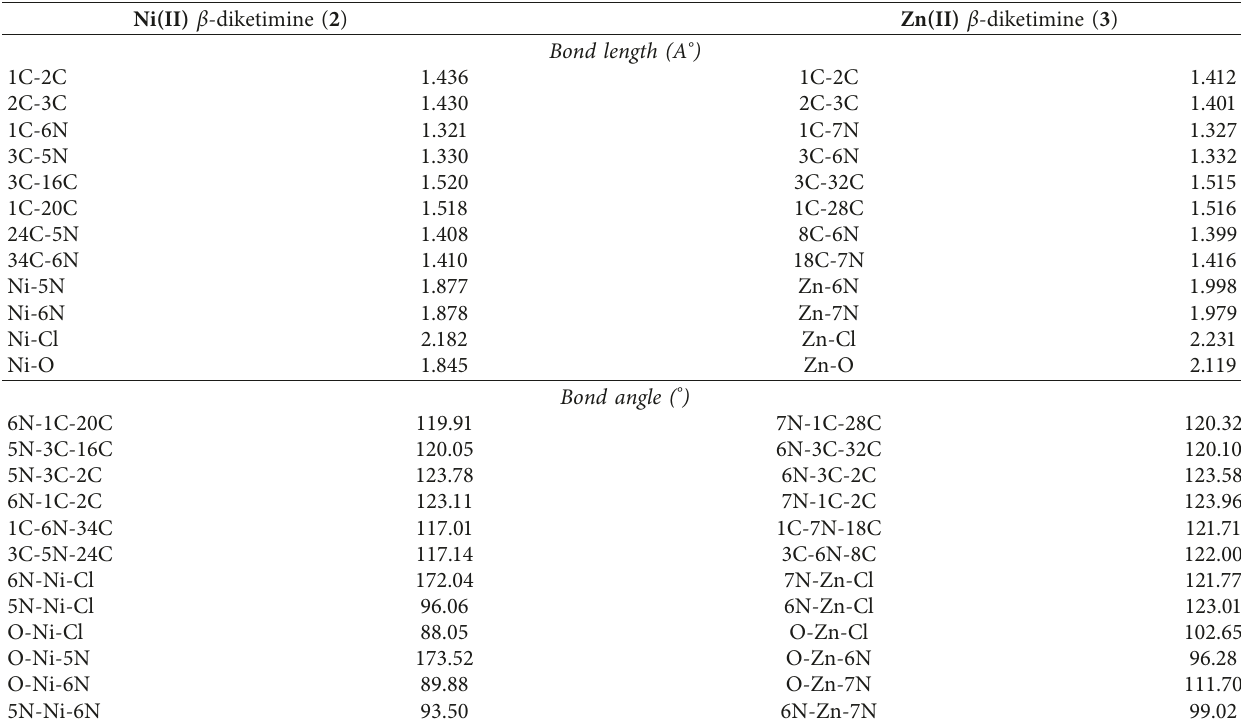
Table 4: Selected bond lengths and bond angles calculated at the M062x method with the 6-31G(d) basis set for complexes 2 and 3 . Ni(II) β -diketimine ( 2 )